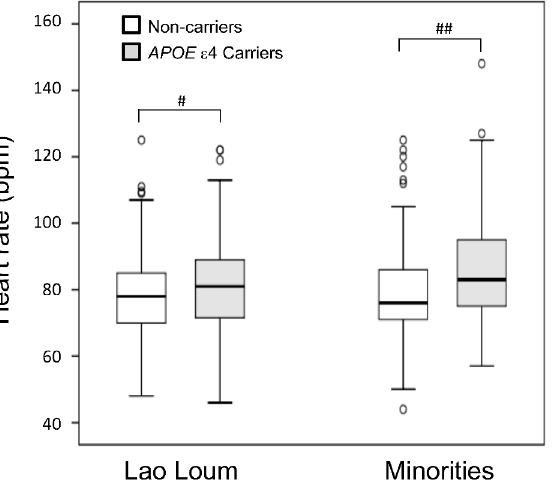
Fig 1. Comparison of APOE ε 4 Carriers with non-carriers. Statistical analysis was performed using the Mann – Whitney U test (#; P < 0.05, ##; P < 0.01, significant difference relative to non-carriers). Outliers are represented by open circles (values between 1.5 and 3 times greater than the interquartile